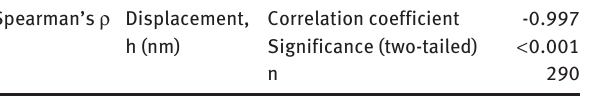
Table 3 Spearman ’ s ρ value for the correlation between n-H and